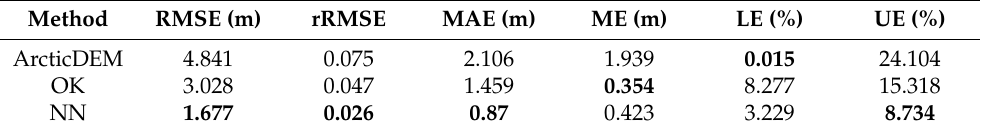
Table 4. Model evaluation metrics at Site-2. Areas outside the triangulation network were not evaluated for both ArcticDEM and the interpolated DTMs. Percentages of lower (LE) and upper (UE) extreme values were calculated in non-ground areas. Bold numbers indicate the best